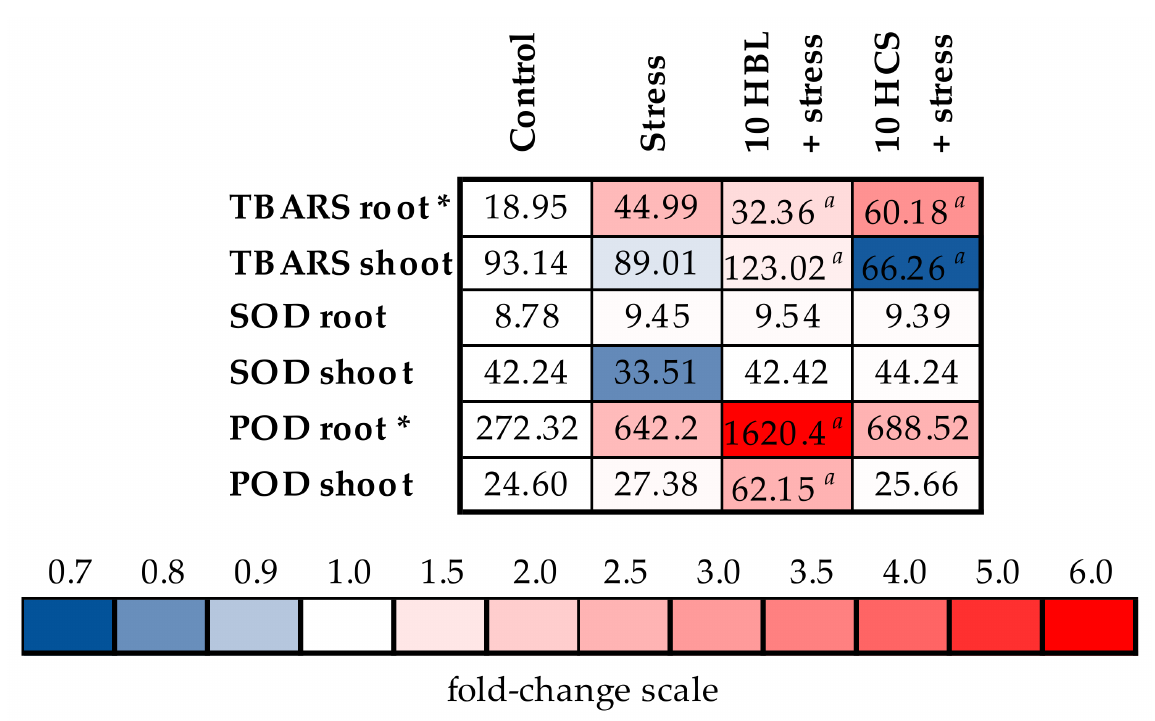
Figure 4. The effects of heavy metal stress and treatment with brassinosteroids on the content of TBARS (ng/g fresh weight) and activity of antioxidant enzymes, SOD (U/g protein) and POD (U/g protein in min), in barley plants. The value in the control plants was taken as 1.0, the relative decrease is indicated in blue, the relative increase is indicated in red. Asterisks (*) indicate significant differ- ences from the control variant, and the a letter indicates significant differences from the polymetallic stress-treated variant ( p <